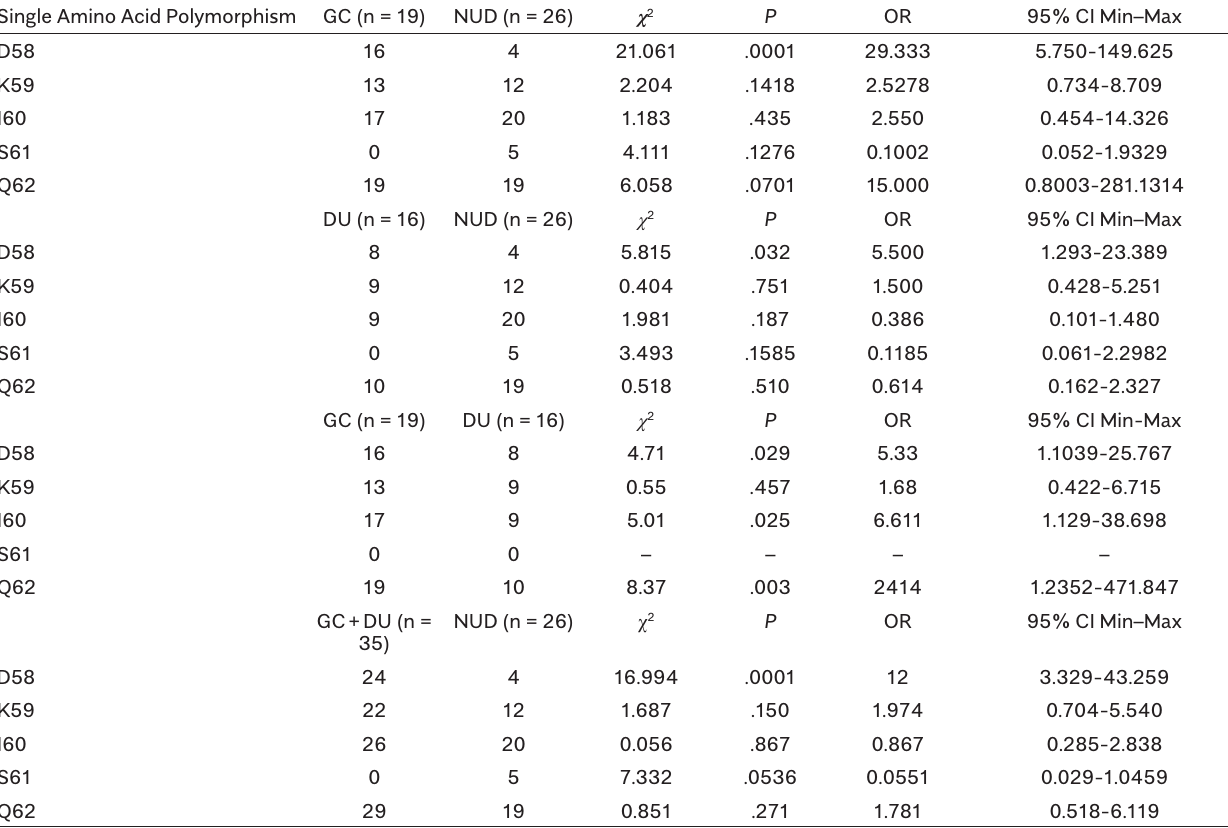
Table 3. The Comparison of the Study and Control Groups in Terms of Single Amino Acid Polymorphisms Detected in the cagLHM Region Single Amino Acid